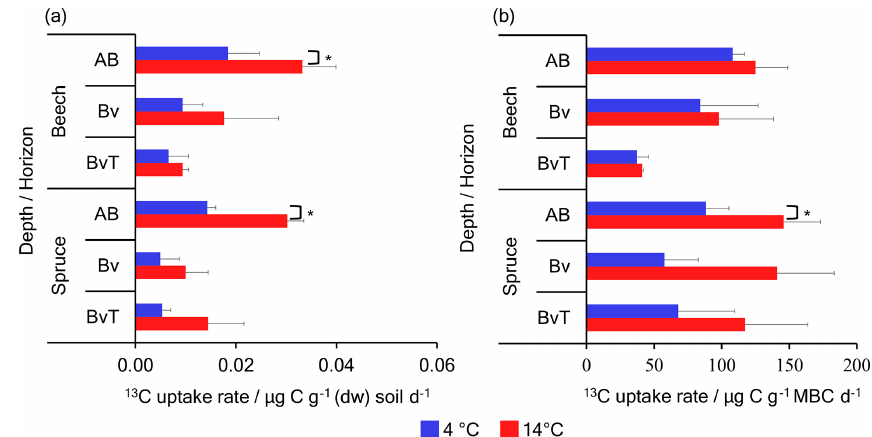
Figure 1. Dark CO 2 fixation rate measured from soil microcosms supplemented with 2% 13 CO 2 at 4 and 14 ◦ C. Shown are (a) 13 C uptake rates in soil expressed in µgCg − 1 ( dw ) soild − 1 (micrograms of carbon per gram dry weight (dw) of soil per day) and (b) 13 C uptake rates into MBC expressed in µgCg − 1 MBCd − 1 (micrograms of carbon per gram of microbial biomass carbon per day) after 21d of incubation with 2% 13 CO 2 at 4 (blue bars) and 14 ◦ C (red bars) across three horizons of the beech and spruce soils. Error bars indicate the standard deviation of incubations from three replicate soil cores. * denotes p < 0 . 05.